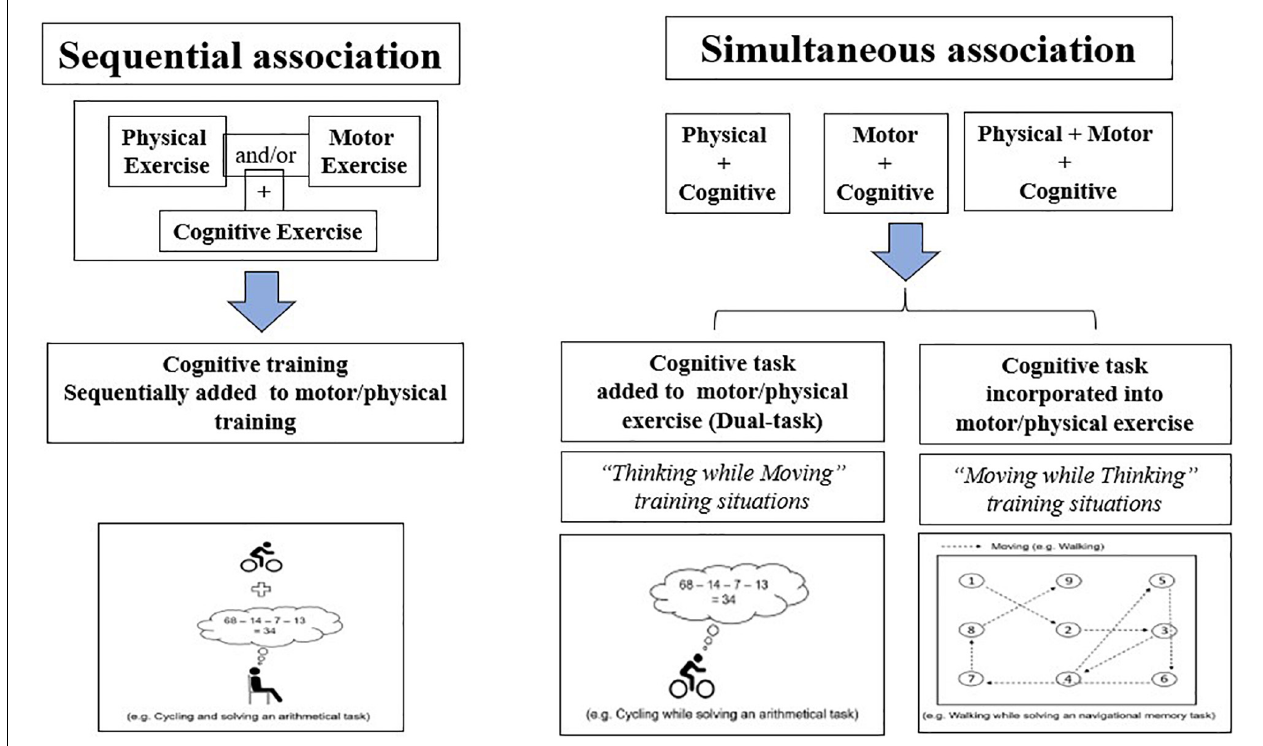
FIGURE 2 | The different combined training interventions (inspired from Herold et al., 2018; Torre et al.,